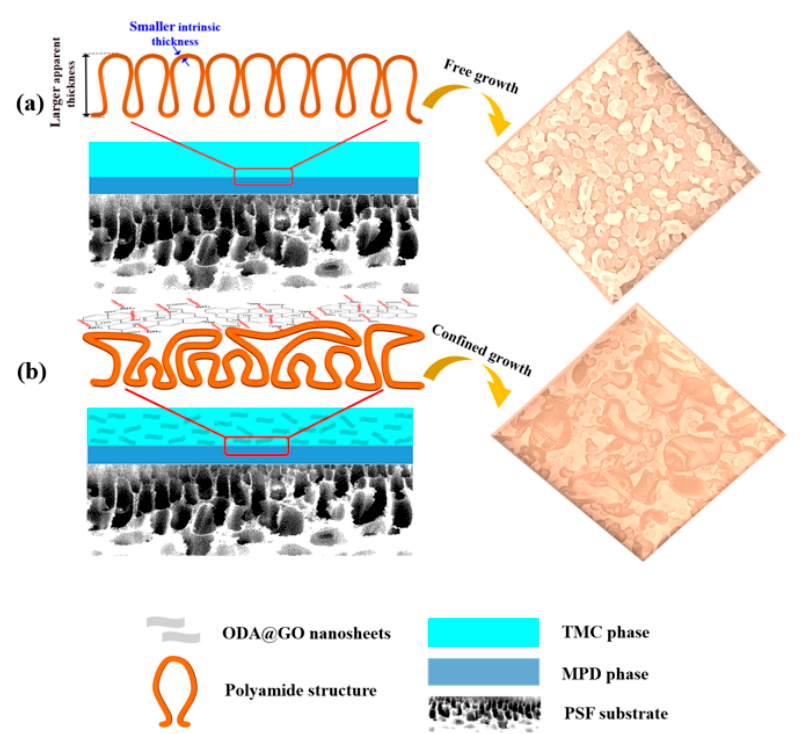
Figure 9. Schematic diagram of the confined growth of ODA@GO: ( a ) No ODA@GO, ( b ) ODA@GO was added as a barrier to constrain the preferred orientation of growth of the PA layer.